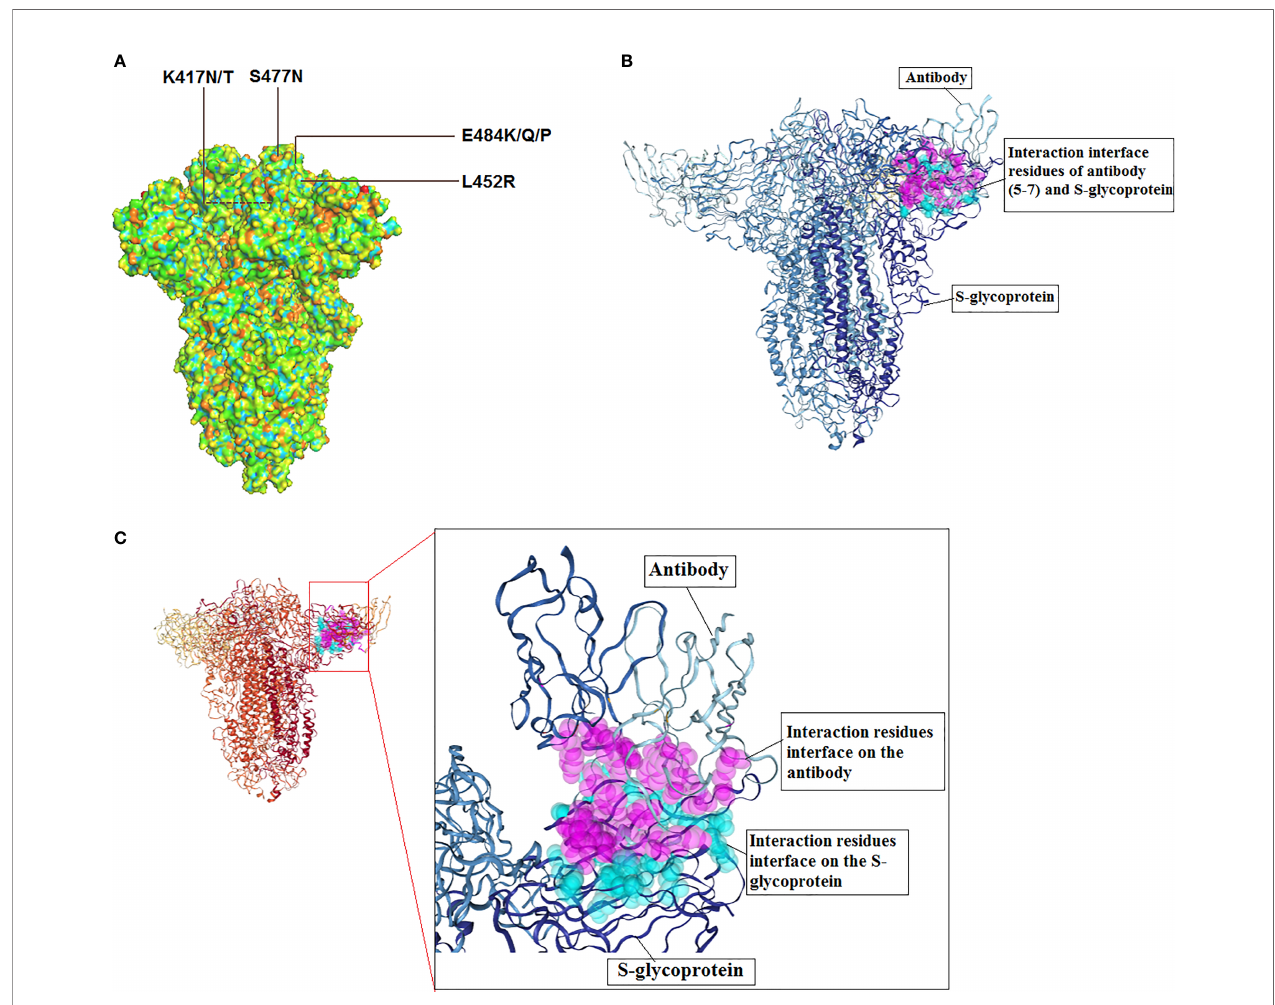
FIGURE 7 | 3D model of S-glycoprotein illustrating the location of signi fi cant mutations in the SARS-CoV-2, important variants related to antibody escape and model for antibody interaction. (A) 3D structure model shows the signi fi cant mutations for antibody escape. (B) A model for SARS-CoV-2 S-glycoprotein and antibody (5-7) interaction. The fi gure was generated using PDB id: 7RW2. (C) Interaction residues interface of antibody and